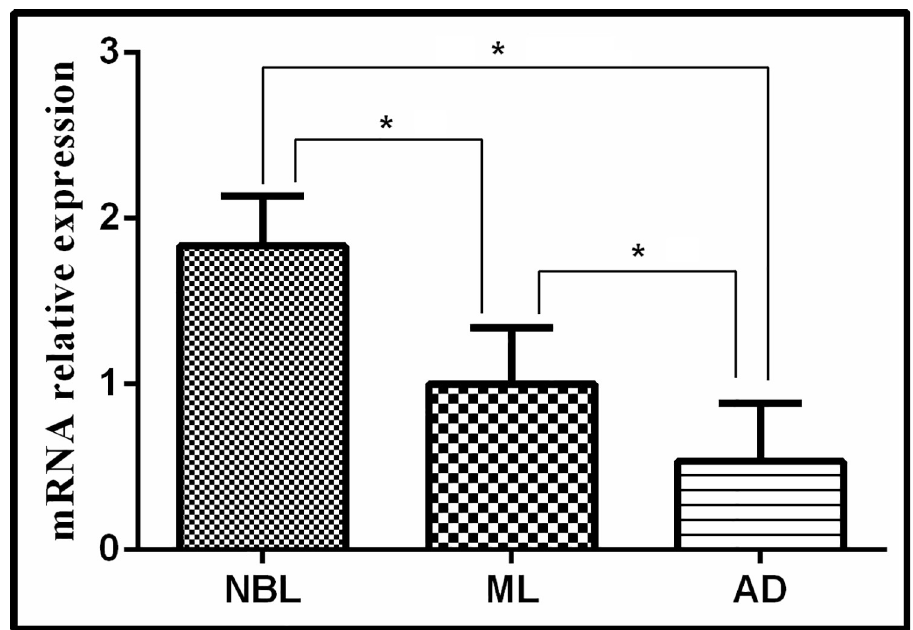
Fig 4. Transcription level of Tsp-GILT by QRT-PCR during various development stages of T . spiralis . NBL: Newborn Larva (relative fold = 1.80); ML: Muscle Larva(relative fold = 1); AD; Adult worms(relative fold = 0.58). Significant differences were observed as � P <